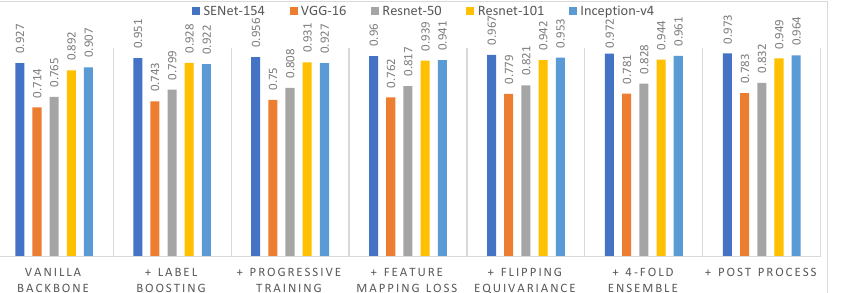
Figure 3. Experimental results with different backbones: VGG-16 [50], ResNet-50, ResNet-101, Inception-V4 [51] and SENet-154 were selected as different backbones. The networks that perform better in semantic segmentation score higher in the classification task of this article. SENet-154 achieved the best results. With the same features used under different backbones, the upward trend of the scores is consistent and the contributions of weak-label boosting and progressive training are at a relatively high level, which proves the robustness of our method.